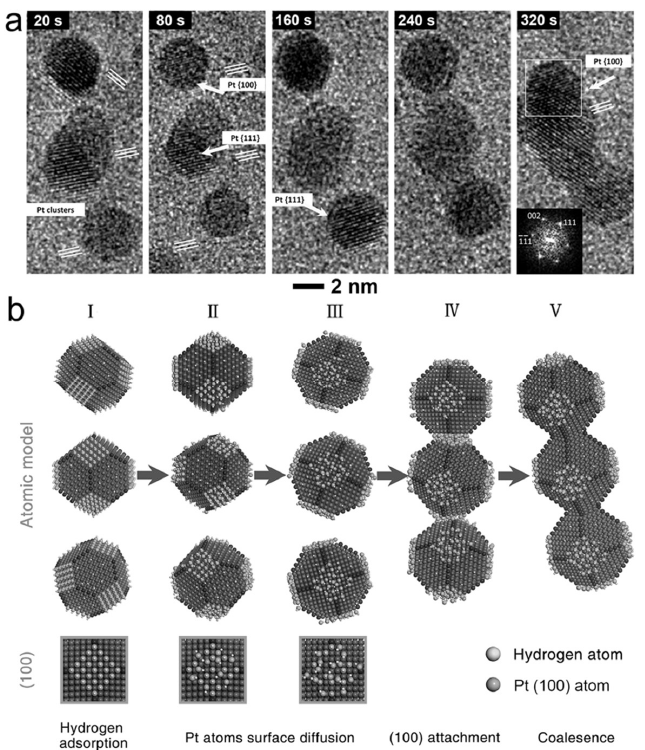
Figure 9. Illustrations of oriented attachment in Pt nanowire formation and corresponding atomic model. The parallel white lines in ( a ) indicate the lattice orientation before and during attachment. Schematic illustrations in ( b ) shows the early connection stage, including hydrogen adsorption, Pt-atoms surface diffusion enhanced by CO, oriented attachment at Pt {100} facets, and finally coalescence to short chain. Reprinted with permission from reference [81]. Copyright 2017 John Wiley and Sons.